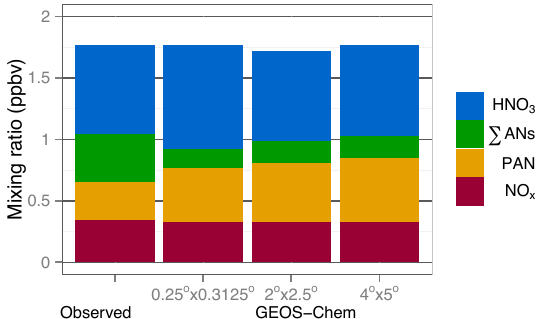
Figure 6. Mean concentrations of reactive nitrogen oxides (NO y ) species over the Southeast US during SEAC 4 RS. Aircraft observa- tions in the mixed layer over the Southeast US domain of Fig. 1 are compared to GEOS-Chem model values at different resolutions. (cid:54) ANs refers to the sum of alkyl and multifunctional nitrates and PAN to peroxyacetylnitrate. Observations are from T. Ryerson for NO x , R. Cohen for (cid:54) ANs, G. Huey for PAN, and J. Dibb for nitric acid (HNO 3 ) (Toon et al.,